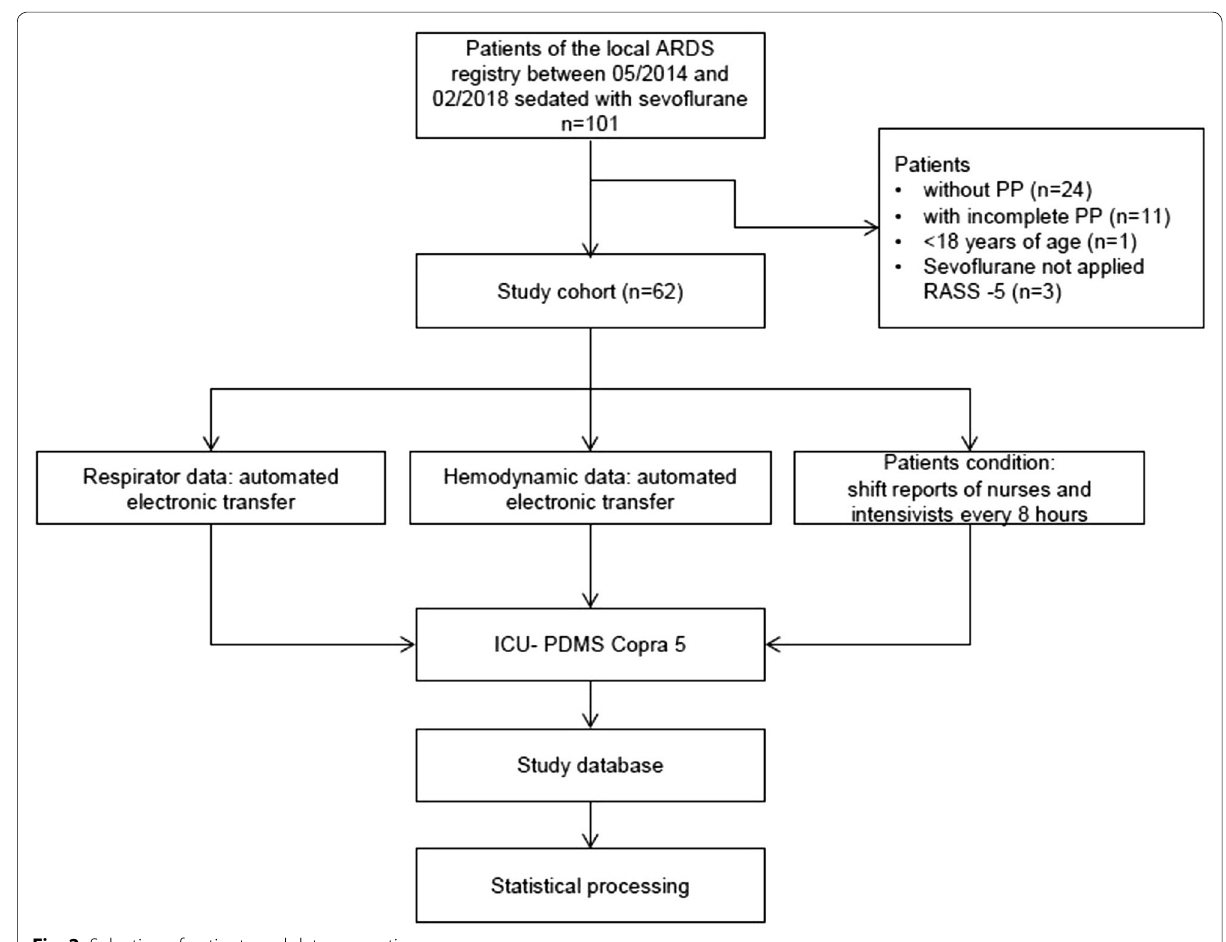
Fig. 2 Selection of patients and data